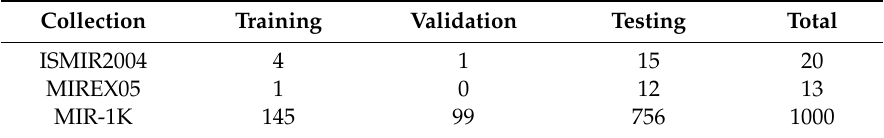
Table 1. Overview of training, validation. and testing